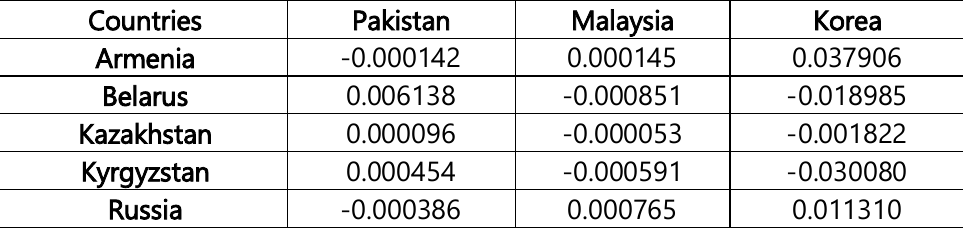
Table 1: Relative Volume Change of GDP in the EEU Member States, % (Source: Own compilation)